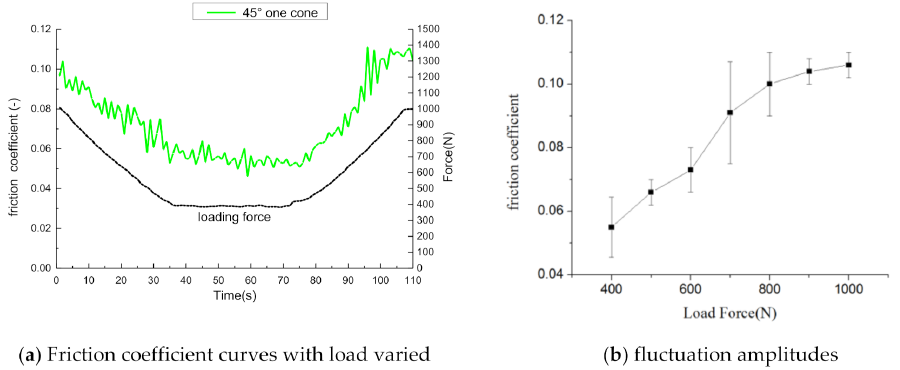
Figure 9. Friction coefficient curves with load varied (T1).